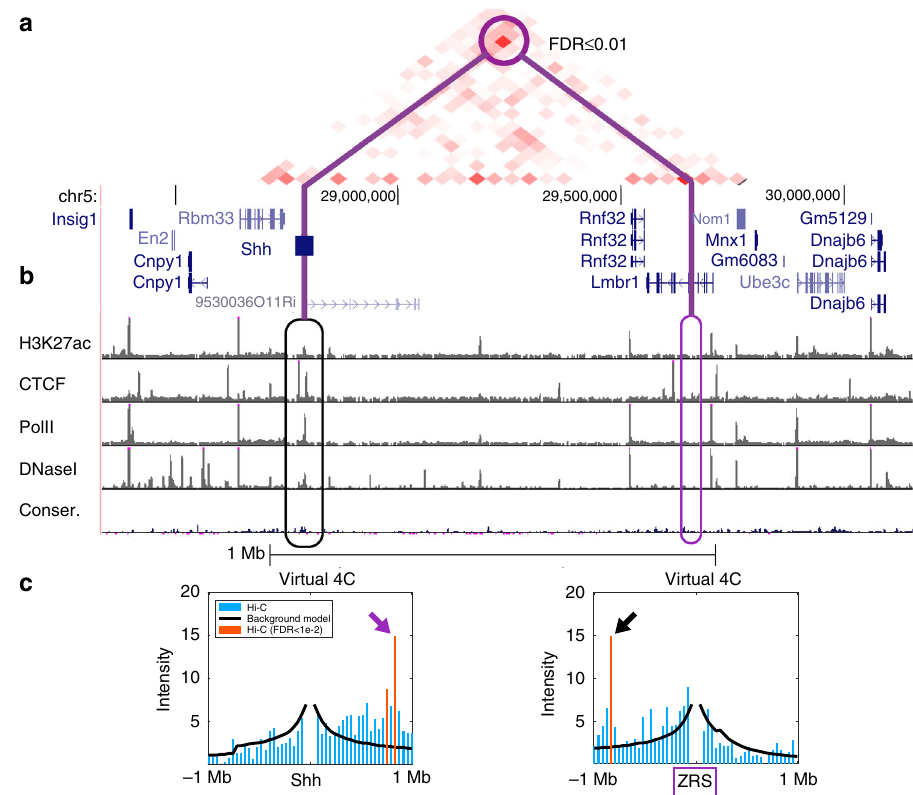
Fig. 7 Shh – ZRS interaction in adult mouse cortex. Signi fi cantly enriched promoter – enhancer interactions (in adult mouse cortex) between Shh and inactive limb-speci fi c enhancer ZRS (chr5:28.3 – 30.2 Mb). a Residual map (measured Hi-C data after subtraction of background model fi tted by PSYCHIC) identi fi es over-represented DNA – DNA interactions between the Shh locus and its limb-speci fi c enhancer ZRS. b Genome-wide ChIP-seq and accessibility data from adult mouse cortex show no active enhancer marks for this enhancer. c . Virtual 4C plots for the Shh (left) and the ZRS (right) loci, comparing Hi-C interactions with the local background model reconstructed by PSYCHIC. Arrows mark signi fi cant between Shh and